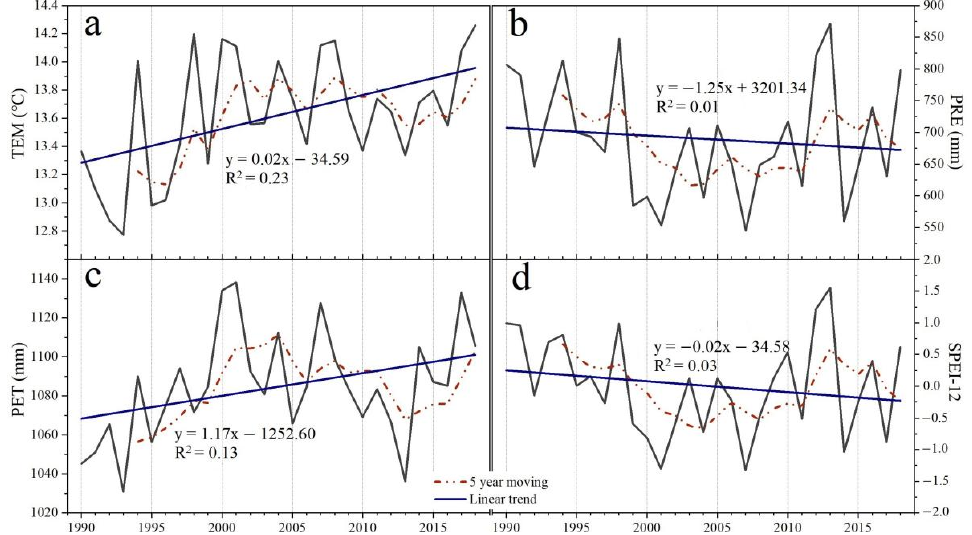
Figure 2. Trends of annual mean temperature (TEM, ( a )), precipitation (PRE, ( b )), potential evapo- transpiration (PET, ( c )) during the growing season (April–October), and SPEI-12 ( d ) in Northeast China (NEC) during 1990 − 2018.